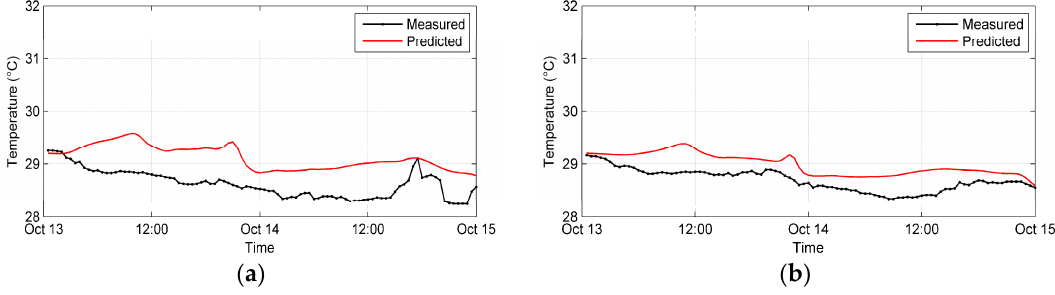
Figure 11. Thermistor measurements and predicted temperature. ( a ) Depth ‐ averaged temperature at mooring TM 1 ; ( b ) Depth ‐ averaged temperature at mooring TM 2 .